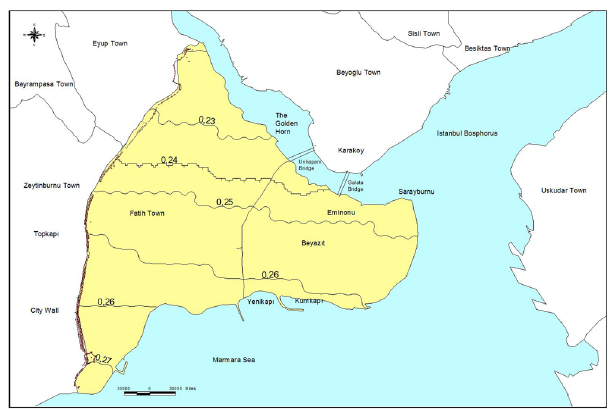
Fig. 14. SA ( T = 0.2s) contour for a 40% probability of ex- ceedance in 50yr for for the historical penninsula of Istanbul (Pois- sonian model) (˙Ince, 2005).